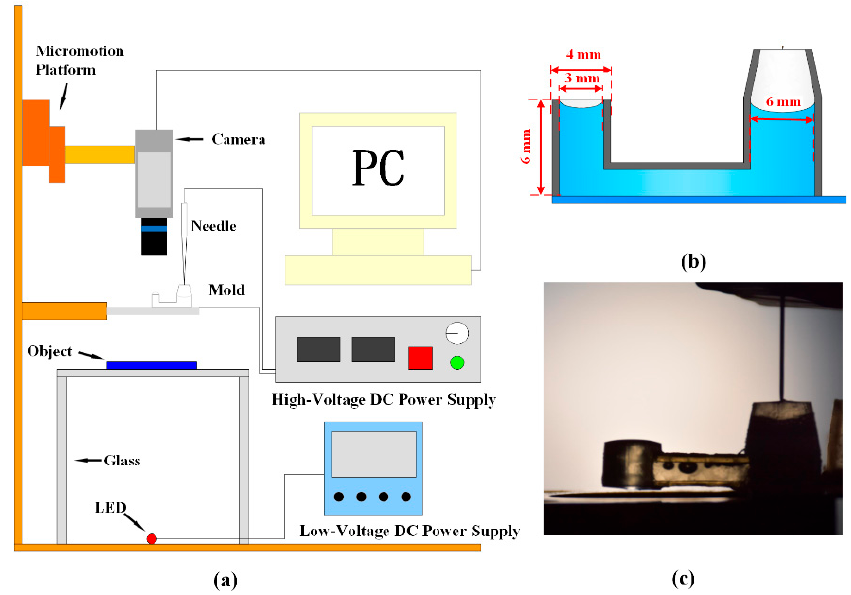
Figure 2. Experimental setup. ( a ) Schematic of experimental setup. ( b ) Schematic of U tube. ( c ) Picture of needle and U tube.